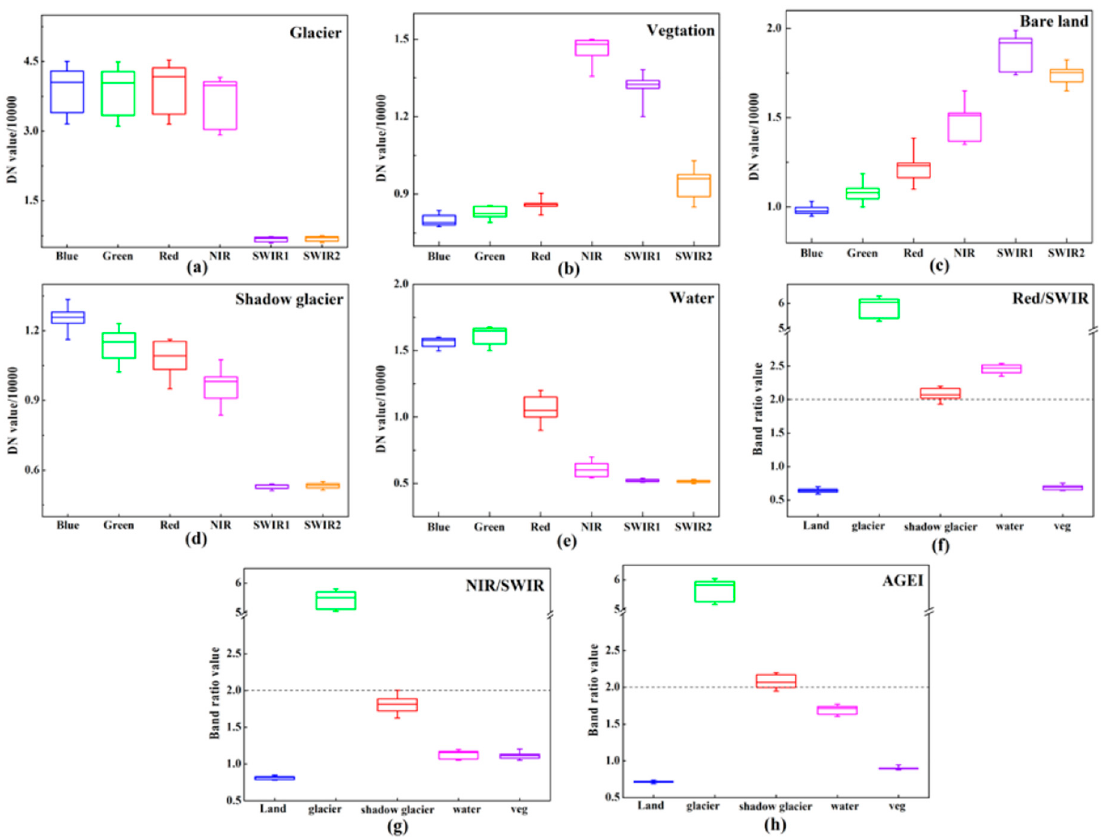
Figure 3. Distributions of pure pixels digital number (DN) values of major land cover types ( a – e ) and distributions of pure pixels band ratio DN values of three different methods ( f – h ). Each box plot explains the locations of the 10th, 25th, 50th, 75th and 90th percentiles using horizontal lines (boxes and whiskers).